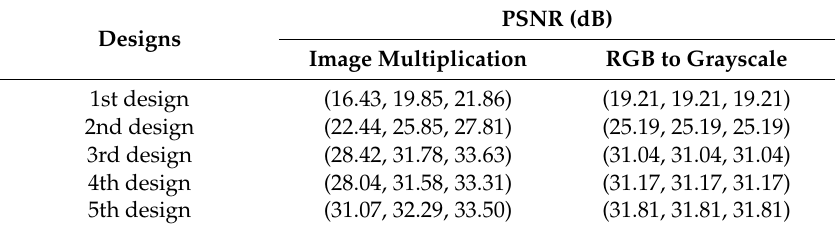
Table 8. Peak signal-to-noise ratio (PSNR) Values.